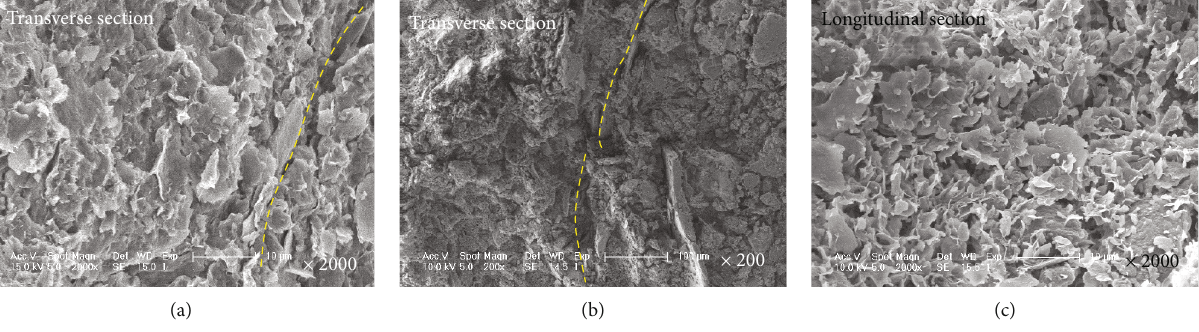
Figure 7: SEM graphs of transverse and longitudinal sections in the slip